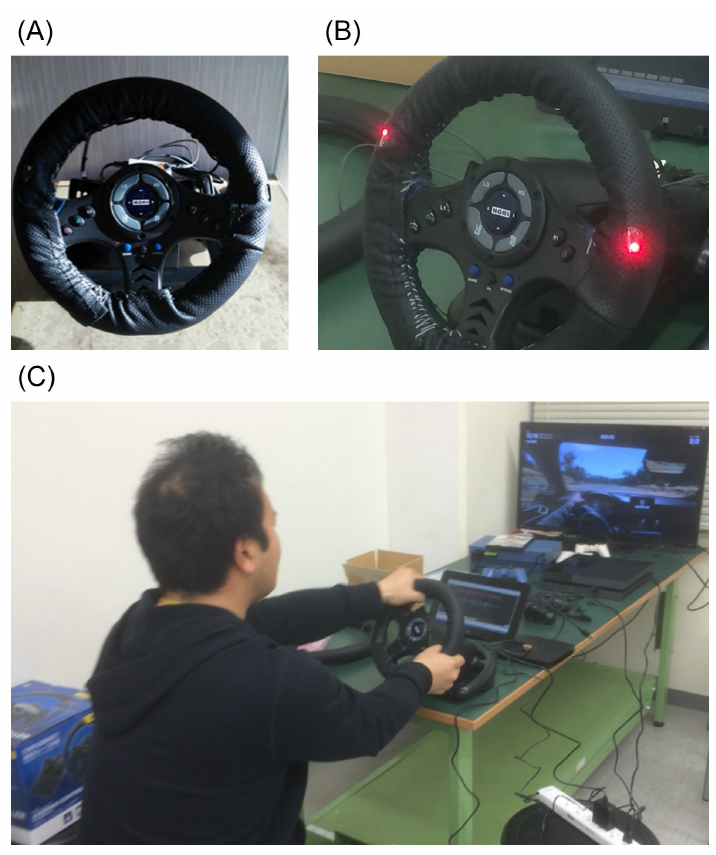
Figure 2. Steering-type measurement system developed by Arakawa et al.: ( A ) appearance of the sys- tem; ( B ) transmitter and receiver LEDs visible on the spoke of the steering wheel; ( C ) demonstration of the operation of the system while playing a driving